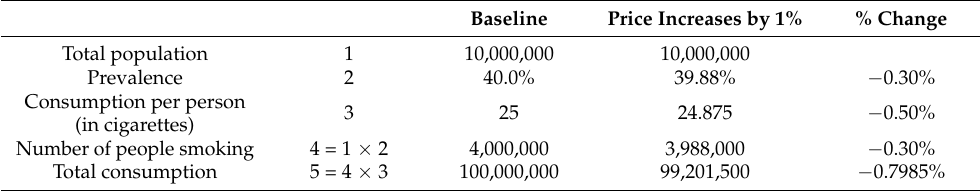
Table A8. Hypothetical example for the calculation of the total demand elasticity. Baseline Price Increases by